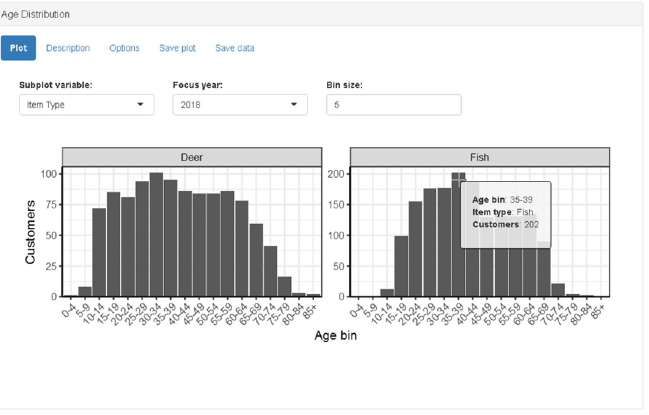
Fig 5. Screenshot of age distribution panel when “item type” is selected as subplot variable. For simplicity, only two item types are shown; additional rows are added automatically to accommodate any number of